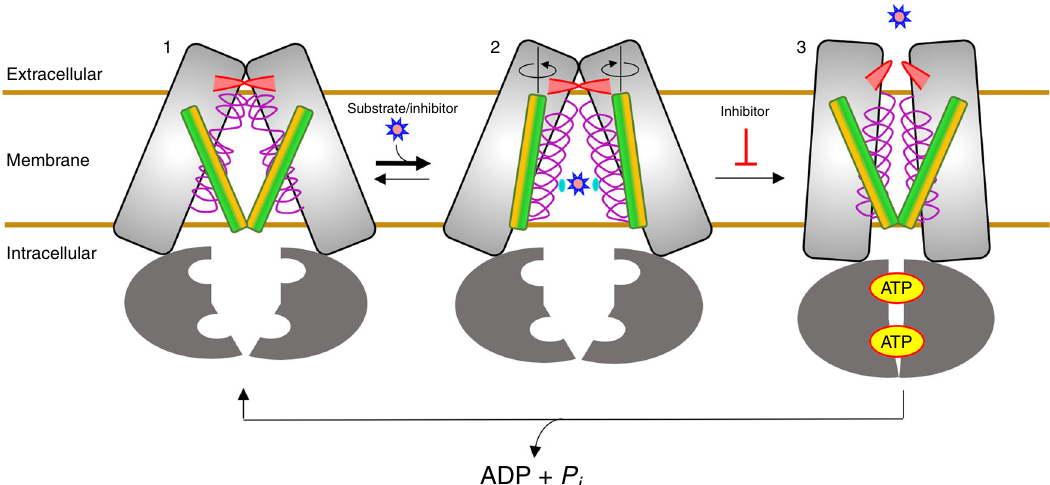
Fig. 5 Model of drug capture and extrusion by ABCG2. In the absence of ligands ABCG2 adopts an apo-closed conformation (1). In this conformation the NBDs are well separated, TM5 (green/yellow bar) is shifted towards the dimer axis, and TM2 (purple spring) is unwound near the center of the helix. Binding of substrates and inhibitors shifts ABCG2 to the inward facing conformation (2). In this conformation TM2 regains helical character, TM5 moves laterally to the sides of the transporter and rotates away from the dimer axis. Bound drug molecules are captured between Phe439 from each monomer (cyan circle). Subsequent binding of ATP in the NBDs causes the TM helix bundles to collapse toward one another, pushing the bound drug molecule through the leucine plug (red fl ipper) and into the extracellular space. ATP hydrolysis resets the transporter to the apo-closed